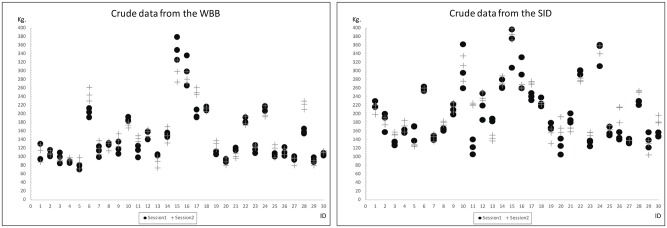
Crude data from the WBB (left) and the SID (right).The horizontal axis shows each individual and the vertical axis show the recorded strength in kilograms for each session.